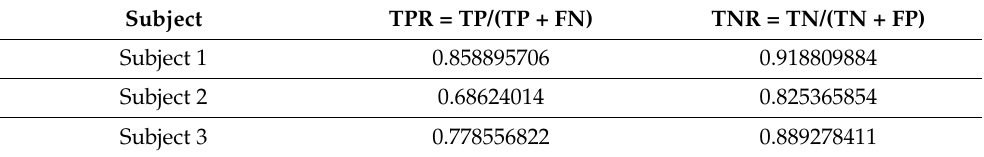
Table 7. True Positive Rate (TPR) and True Negative Rate (TNR) values for subjects 1, 2, and